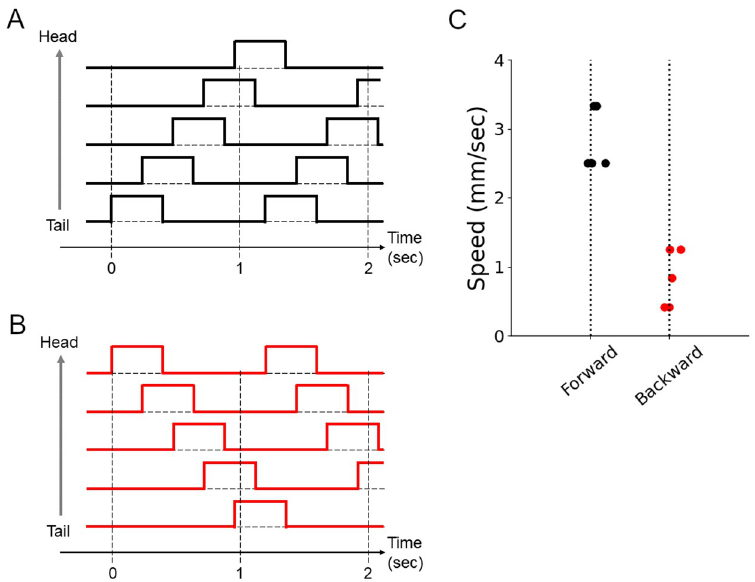
Fig 9. Forward and backward crawling in the soft robot. (A and B) Control signals for forward (A) and backward (B) locomotion of the soft robot. (C) Locomotion speed of the soft robot in forward and backward locomotion at the vacuum pressure of -30 kPa. Forward crawling was faster than backward crawling (p-value = 9.3 x 10 − 5 by Welch’s t-